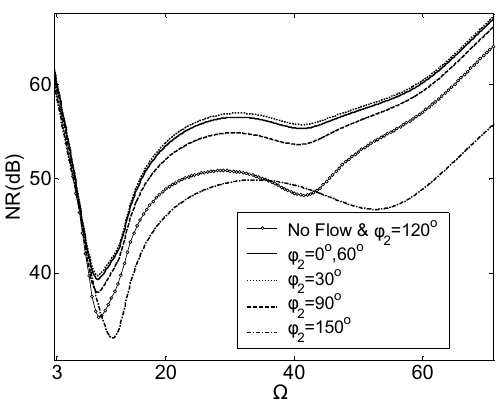
Fig. 13. Effects of the incident angle of the exterior airflow on noise